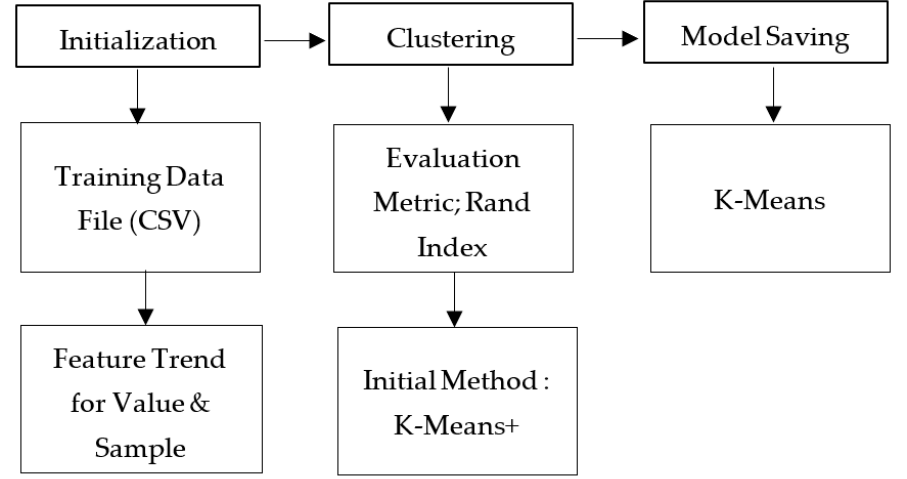
Figure 5. Block diagram of K-means program.